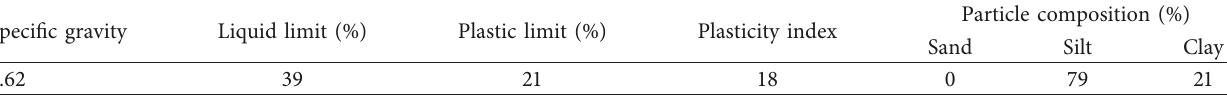
Table 1: Basic physical and mechanical properties of the soil samples.